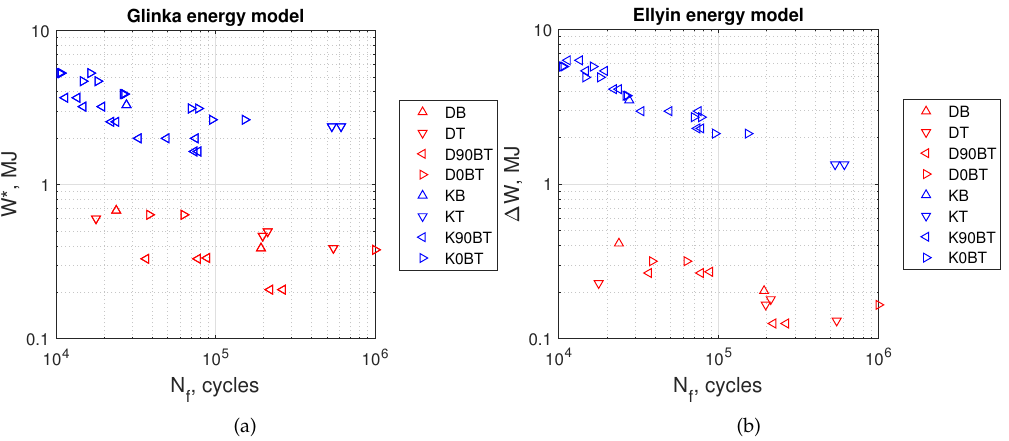
Figure 15. ( a ) Glinka parameter in Equation (9), ( b ) Ellyin energy parameter in Equation (11). Tests at kinematic load: K90BT, out of phase; K0BT, in phase; KB, bending; KT, torsion. Dynamic loads: D90BT, out of phase; D0BT, in phase; DB, bending; DT,